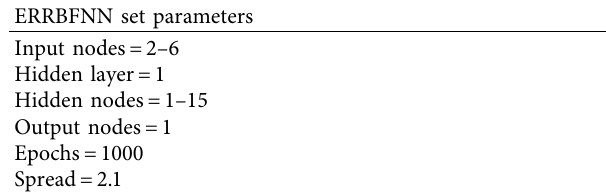
Table 3: Set parameters of the proposed